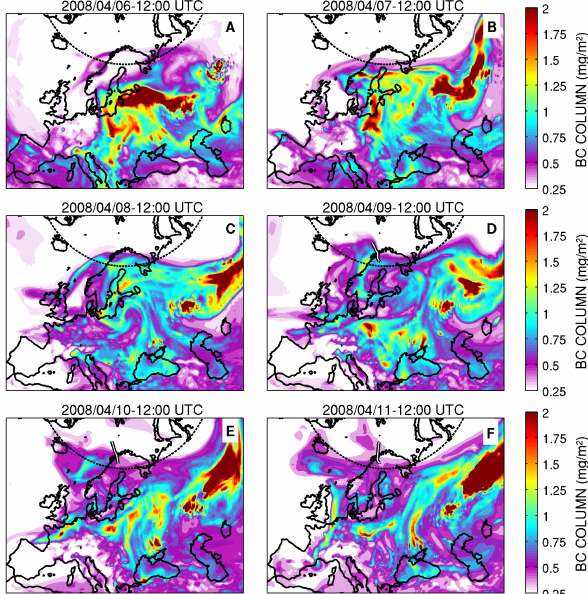
Figure 4. Simulated BC column on 6–11 April 2008 (12:00UTC). POLARCAT-France flight tracks are indicated in white, with a black